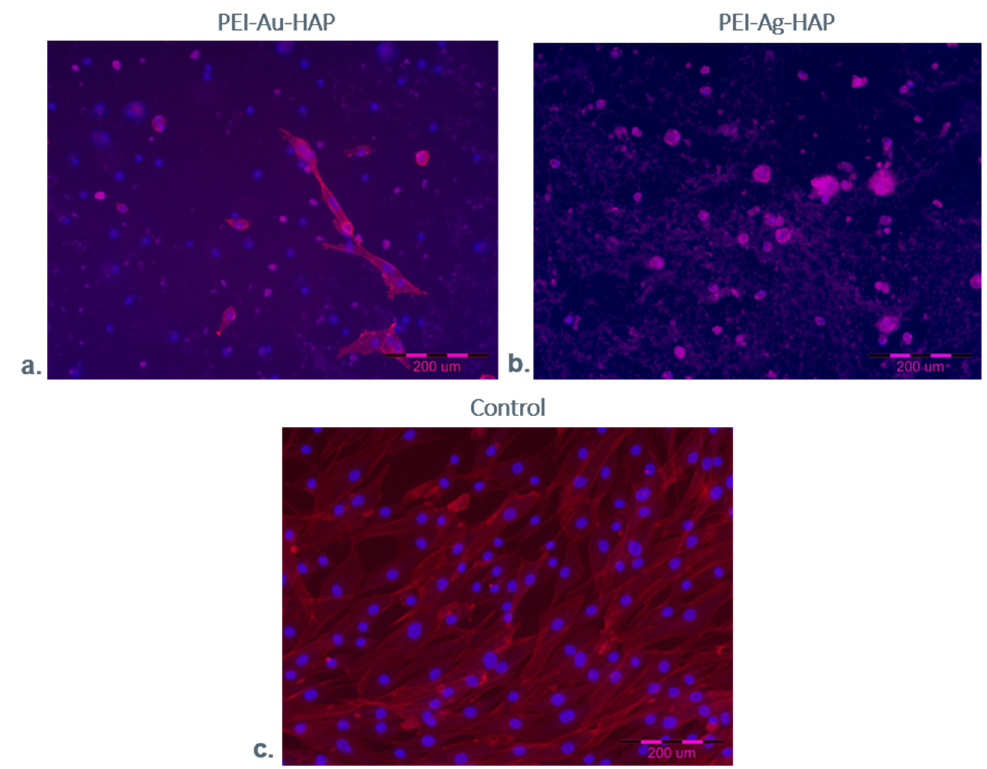
Figure 13. Fluorescence microscopic visualization of HDF cells after 7-day culture within a membrane. Key to symbols: ( a ) PEI-Au-HAP membrane; ( b ) PEI-Ag-HAP membrane; ( c ) Control. Cell nuclei are visualized by staining with DAPI blue fluorescent dye; cell cytoskeleton is stained red with F-Actin.